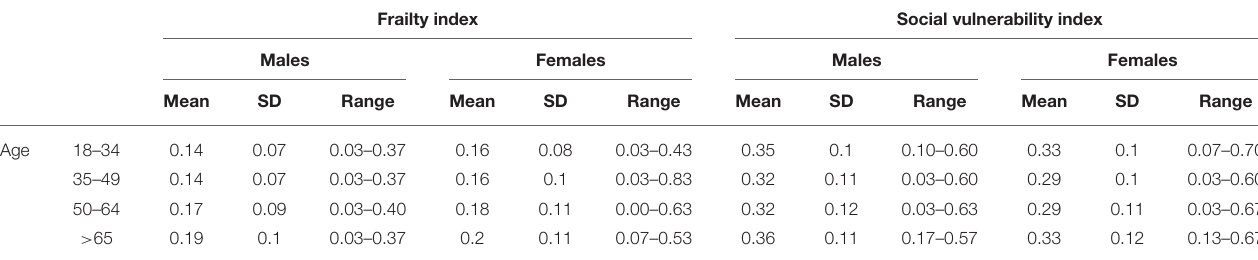
TABLE 2 | Descriptive statistics of frailty and social vulnerability indices. Frailty index Social vulnerability index